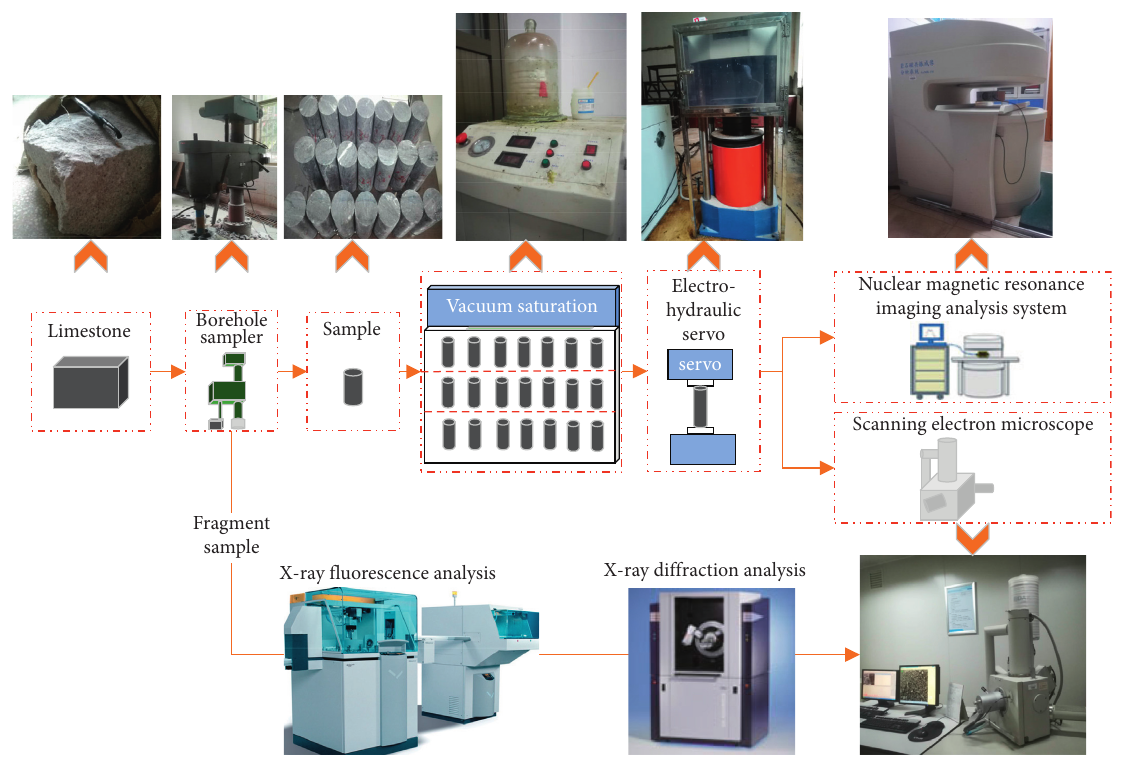
Figure 2: Experimental instrument